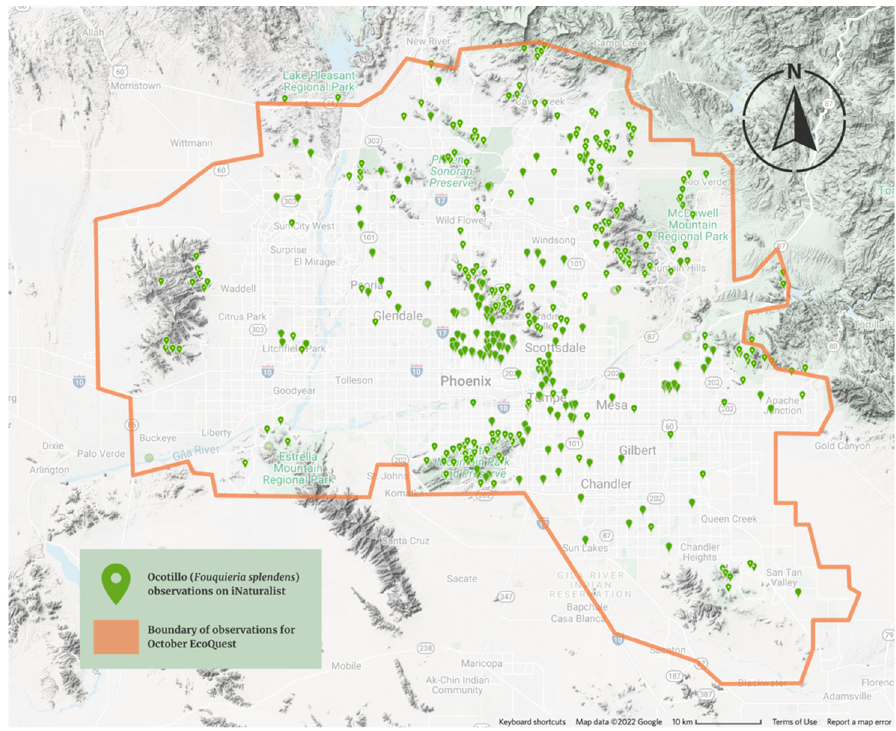
Figure 5. iNaturalist map showing observations of ocotillo ( Fouquieria splendens) and possible con- nectivity corridors in the Phoenix metropolitan area, accessed on January 5, 2021.